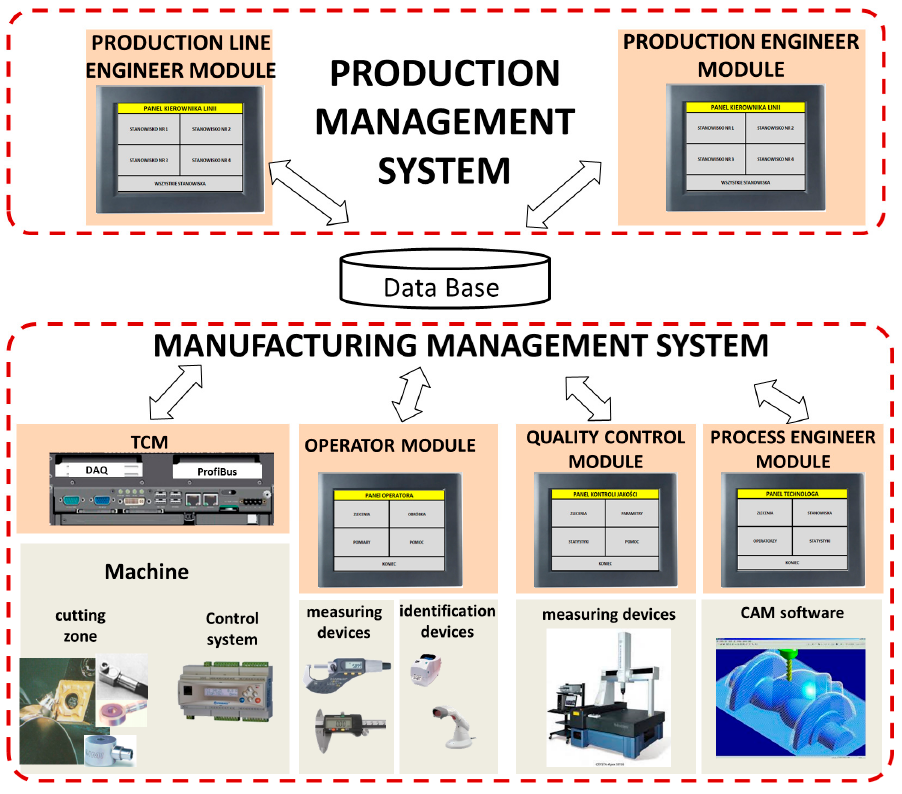
Figure 1. Diagram of the TCM concept [46].